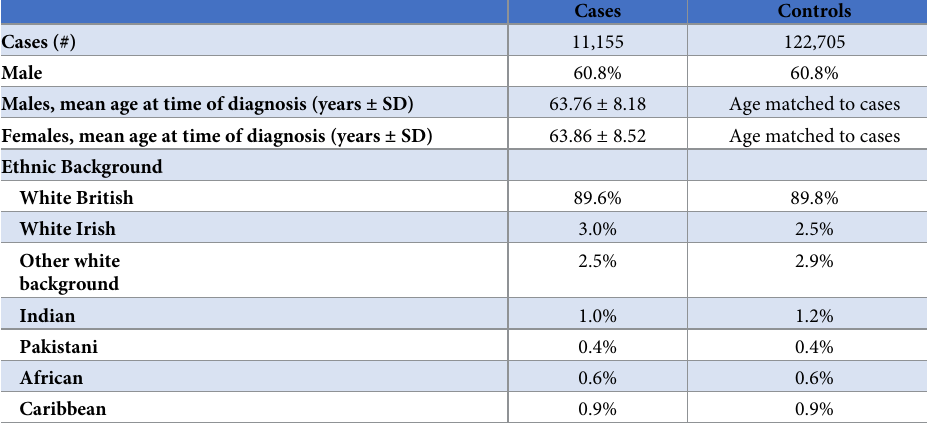
Table 2. Demographic characteristics of individuals with cerebrovascular disease and their respective